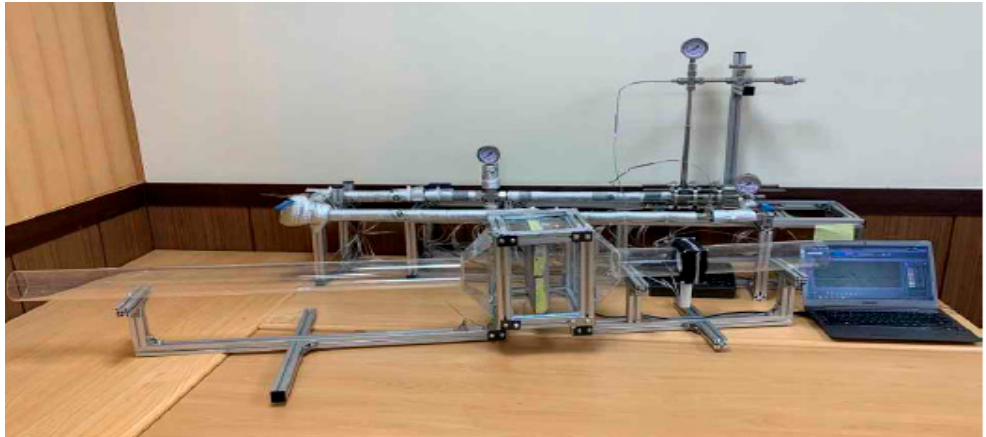
Figure 8. Photograph of an indirect experimental device with a heater core.